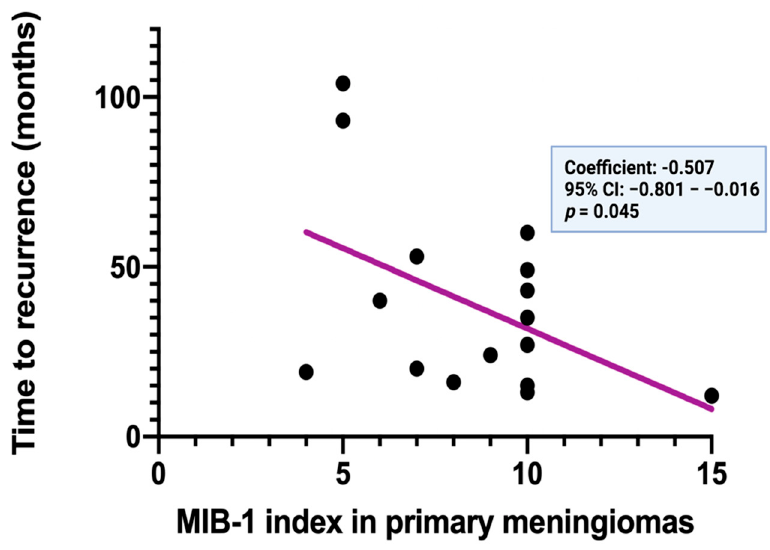
Figure 4. Time to recurrence (in months) in relation to the MIB − 1 labeling index of 16 primary cranial meningiomas.